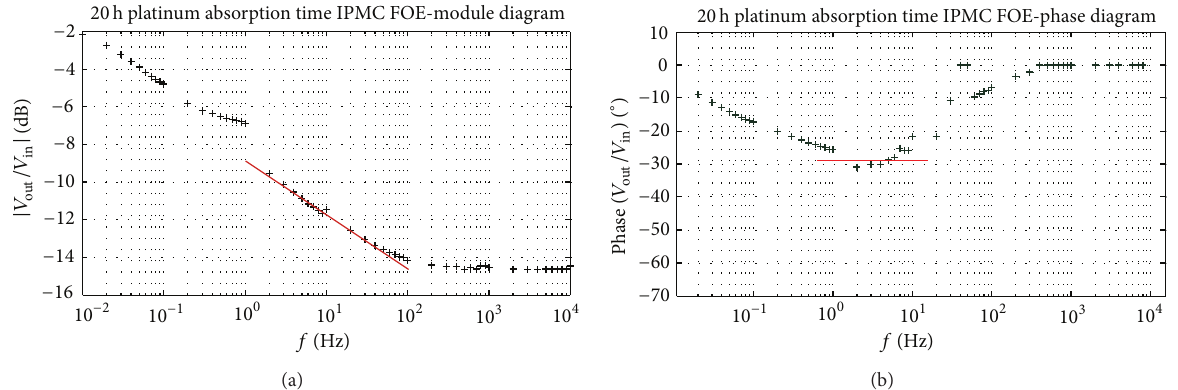
Figure 11: (a) Module and (b) phase diagrams of the ratio V out / V in in the complete experimental frequencies range: 10mHz to 10kHz for the IPMC device at 20 h absorption